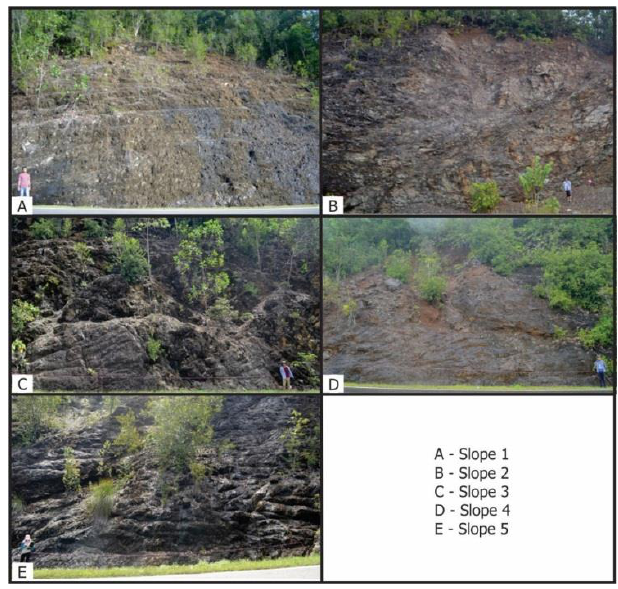
Figure 1: The geological map, location of the study area and slope